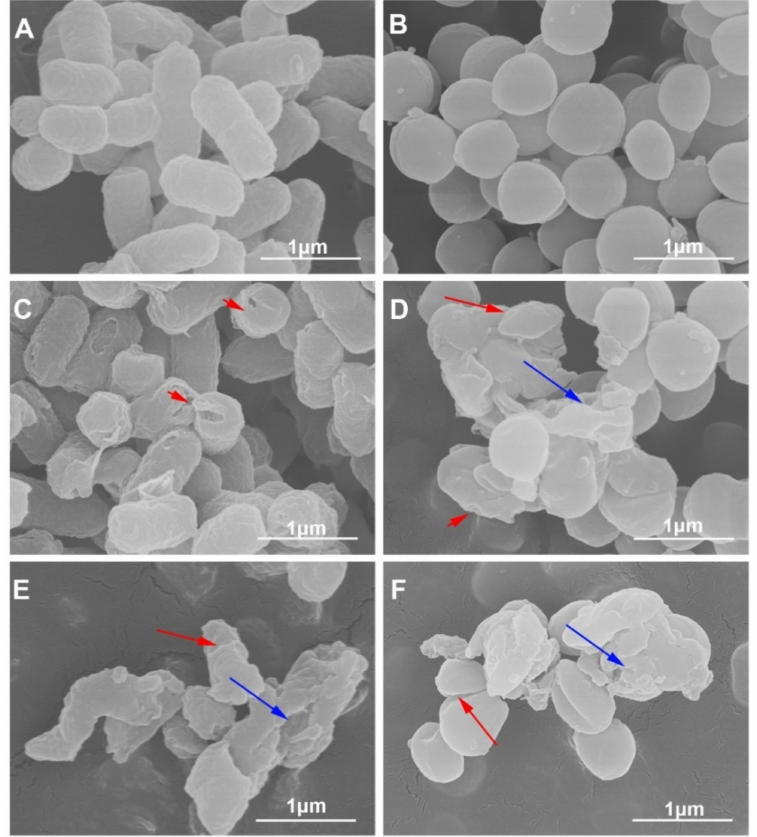
Figure 5. Morphological changes of bacteria treated with or without Z-d14CFR. Scanning electron microscopy (SEM) observation of E. coli ATCC25922 and S. aureus ATCC29213 treated with 10 mM PBS or 2 MIC Z-d14CFR for 3 h. E. coli ATCC25922 ( A ) and S. aureus ATCC29213 ( B ) treated with 10 mM PBS. E. coli ATCC25922 ( C , E ) and S. aureus ATCC29213 ( D , F ) treated with Z-d14CFR. The bacteria showed membrane breakage (red short arrows), cells shrinkage (red long arrows) and rupture (blue long